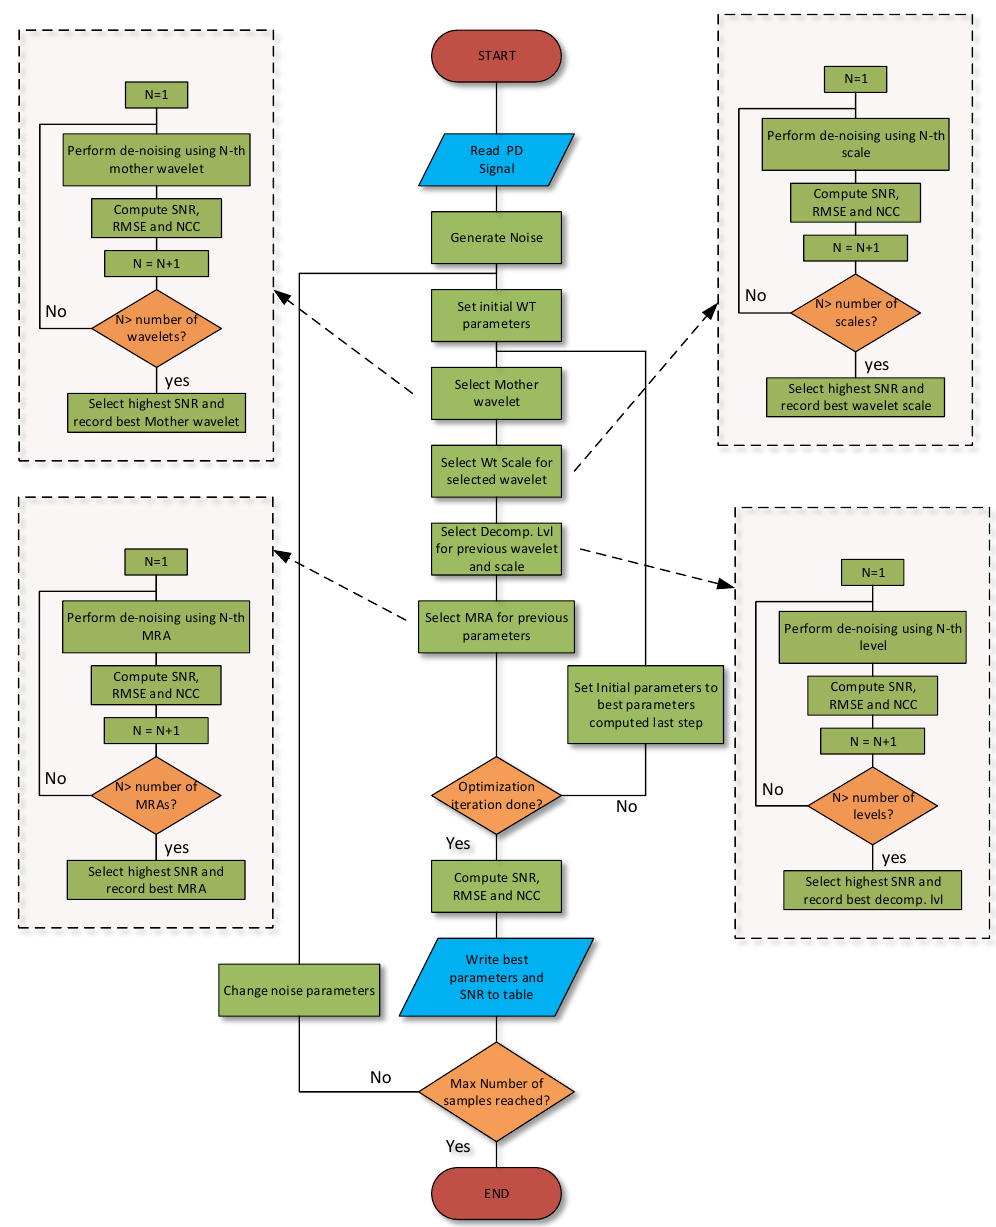
Figure 10. The proposed algorithm reads the PD signal with the noise or separately, which is then decomposed using MODWT parameters that update each iteration in a nested loop. SNR and NCC are computed for each step to estimate the performance numerically until the stop condition is